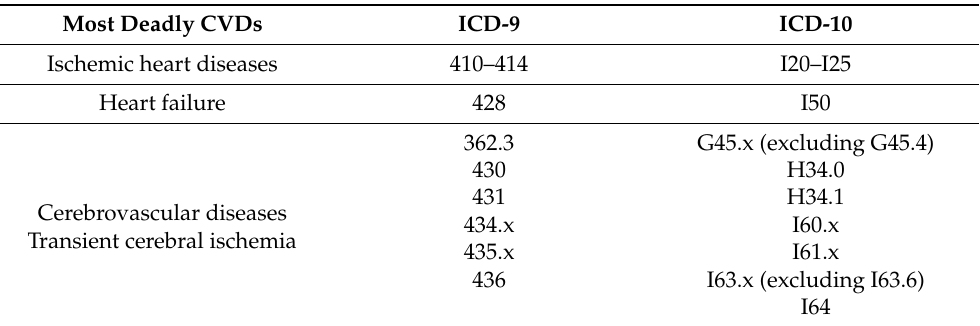
Table 1. ICD-9 and ICD-10 for considered CVDs in this study.